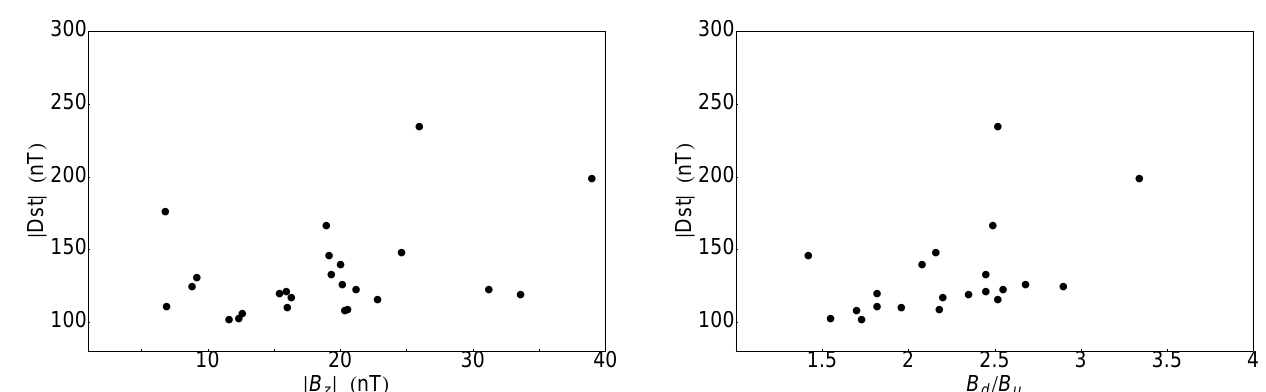
Figure 5. Scatter plots between Dst index and Mach number ( left ) and duration of sheath region ( right ).